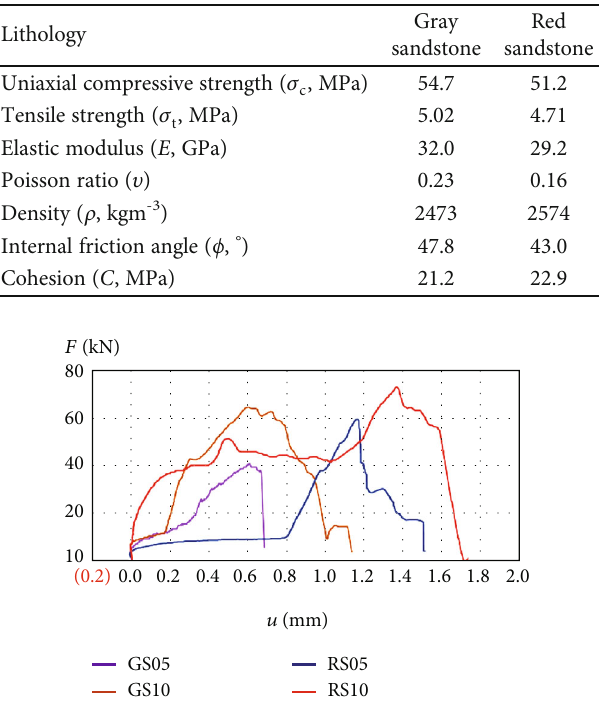
Figure 4: Load-displacement curves of four di ff erent sandstone samples.